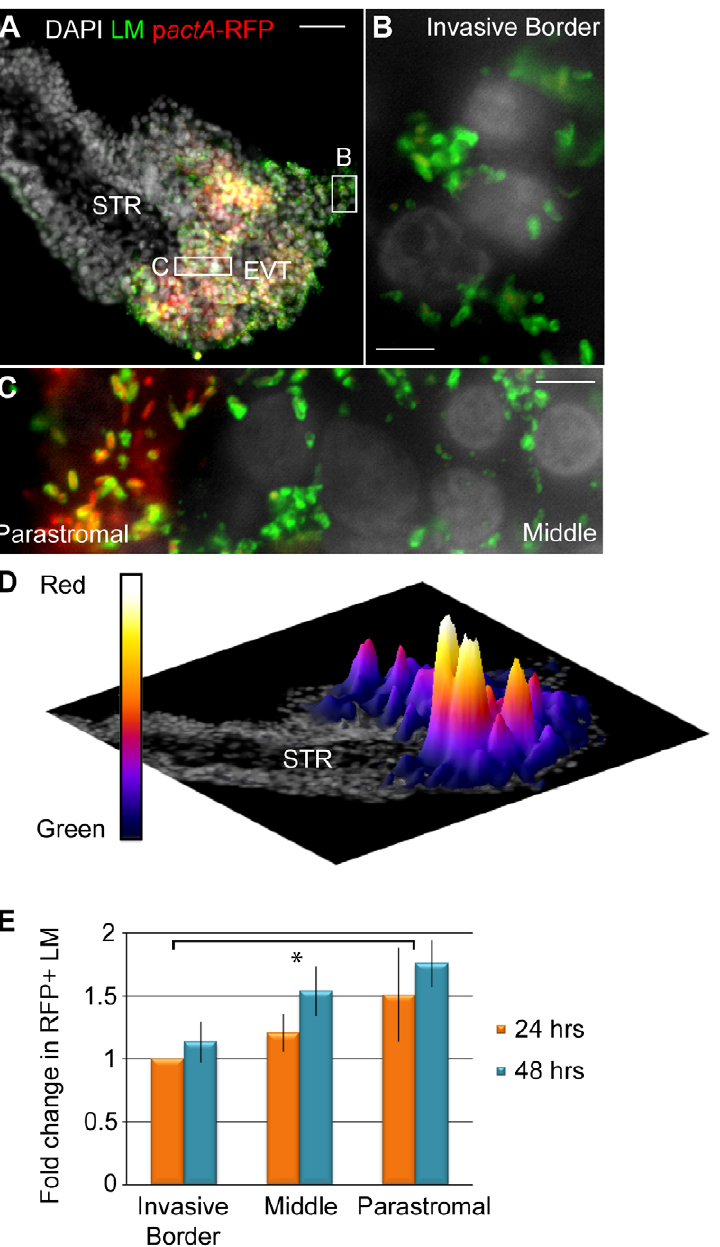
Figure 7. L.monocytogenes (LM) vacuolar escape rates vary across subpopulations of trophoblasts. ( A ) Representative image of placental explant 24 hours post-inoculation (p.i.) with p actA -RFP LM counterstained with anti-LM (green). DAPI counterstain (white). STR = stroma. ( B,C ) Close-up examples of Invasive Border EVT ( B ), Parastromal trophoblasts and middle EVT ( C ). ( D ) Rotated image of placental explant from panel A with superimposed surface plot representing areas of highest RFP expression in relation to total bacterial green signal. Highest peaks are in the parastromal trophoblast region, where vacuolar escape rates are highest. ( E ) Percent RFP-expressing bacteria in each trophoblast subpopulation were enumerated at 24 and 48 hours p.i. in villi where all 3 subpopulations were infected. RFP expression was normalized to the 24-hour time point in invasive border EVT from the same placenta. Results from 3 independent experiments were expressed as average fold-change in comparison to the escape rate in invasive border EVT at 24 hours. Bars are SEM. Asterisk represents significant difference